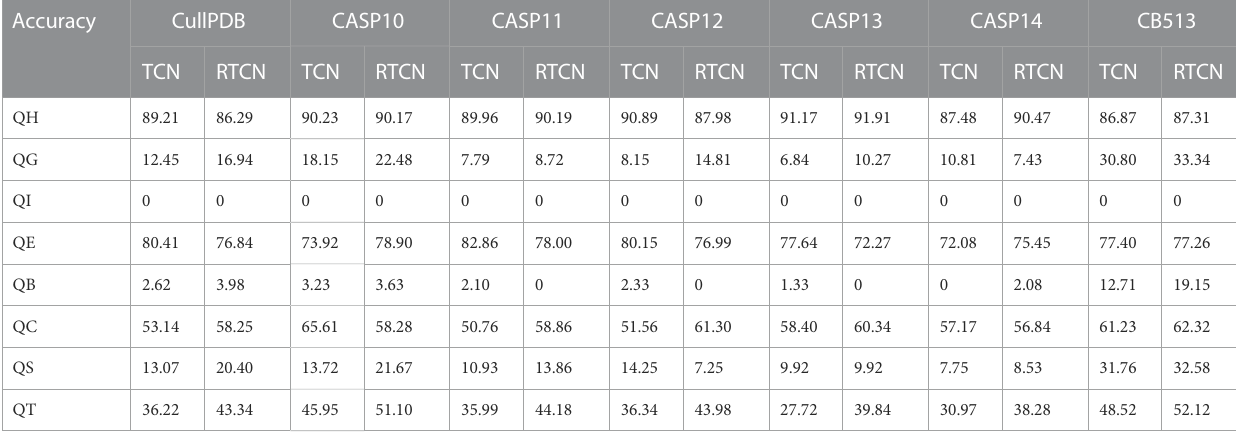
TABLE 3 Single-type accuracy comparison of TCN and RTCN on seven datasets.